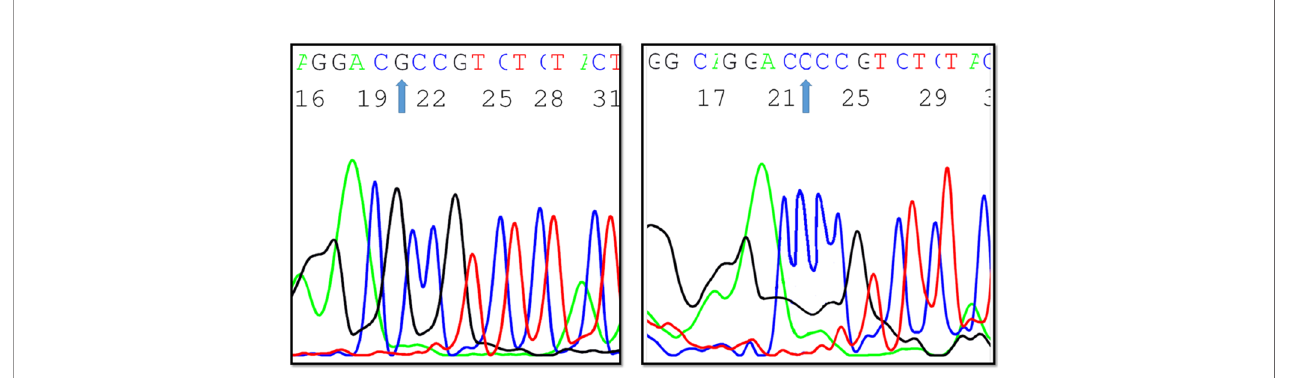
FIGURE 3 | A Sanger sequencing chromatogram depicting EpCAM -935 C/G variants (created by ABI Genetic